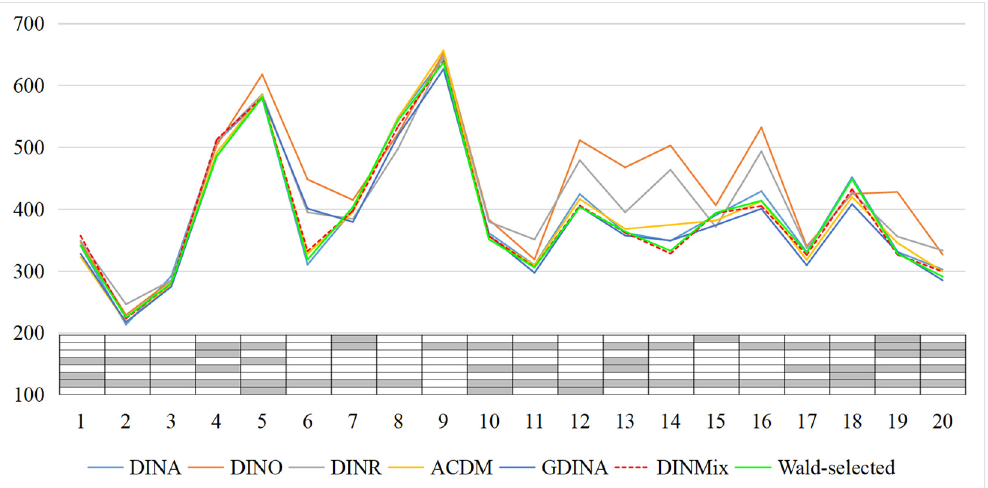
Figure 8. Item-level –2LCPO of seven models for the fraction subtraction data. Note: DINA = deterministic input, noisy ‘and’ gate model; DINO = deterministic input, noisy ‘or’ gate model; DINR = deterministic input, noisy ratio model; ACDM = additive cognitive diagnosis model; GDINA = generalized DINA model; DINMix = deterministic inputs, noisy mixed model; Wald-selected = selected mixing model via Wald test.